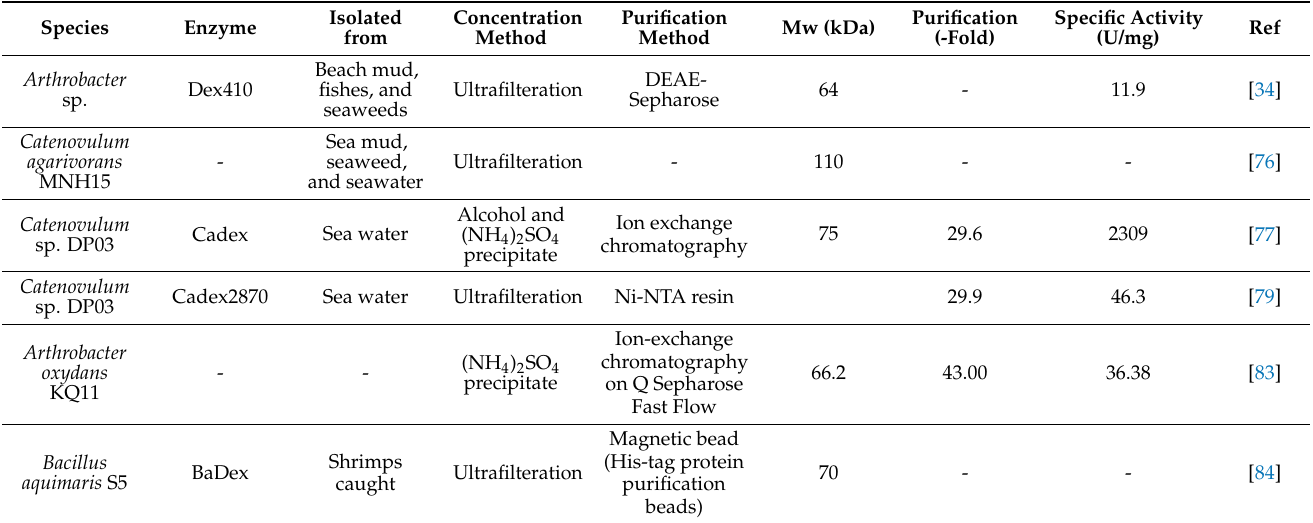
Table 1. Dextranase producing bacteria isolated from different marine sources and their isolation and purification